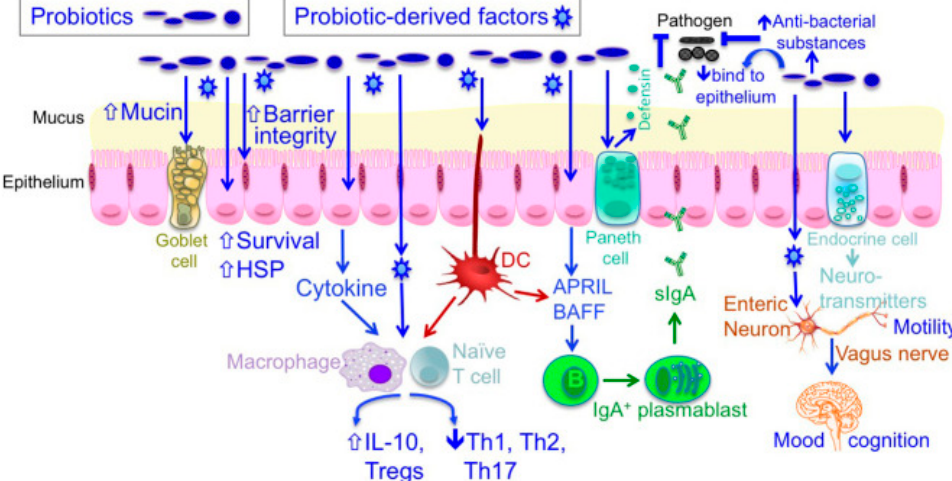
Figure 3. Cellular and molecular probiotics actions. Probiotics guaranteed the preservation of barrier structure and function and the blockade of apoptosis in intestinal epithelial cells through mucus production, survival, and cytoprotective responses. Some probiotic ‐ derived factors, such as polysaccharide A (PSA), modulate the host immune responses through the toll ‐ like receptors (TLR) ‐ 2 in dendritic cells (DC), resulting in increased regulatory T cells and interleukin 10 (IL ‐ 10) production as well as the downregulation of T helper cells (Th1, Th2, Th17) activity. p40, a Lactobacillus rhamnosus GG (LGG) ‐ derived soluble protein, upregulates EGF ‐ receptor ‐ dependent production of a proliferation ‐ inducing ligand (APRIL) in intestinal epithelial cells, contributing to increased conversion of B cells in plasmablast and consequently enhanced production of secretory immunoglobulin A (sIgA) in the intestinal tissue. Probiotics participate in gut–brain communication through the activation of the vagal pathway—independently of brain ‐ derived neurotrophic factor production—positively affecting responses to stressful, anxiogenic, and depressive stimuli. Reproduced with permission from Yan et al. [105] under Creative Common License.